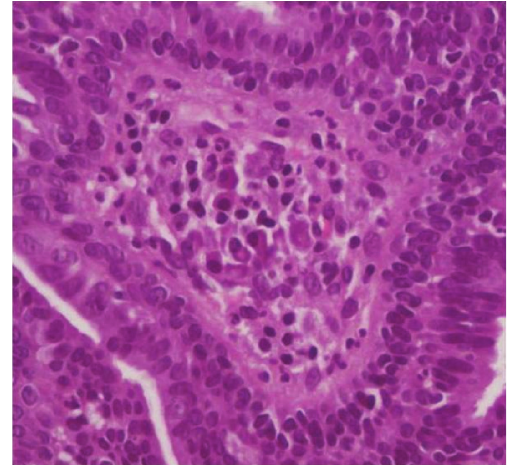
Figure 4: Hematoxylin-eosin stain (40x) showed the presence of focal areas infiltrated by plasma cells and lymphocytes in the stroma.